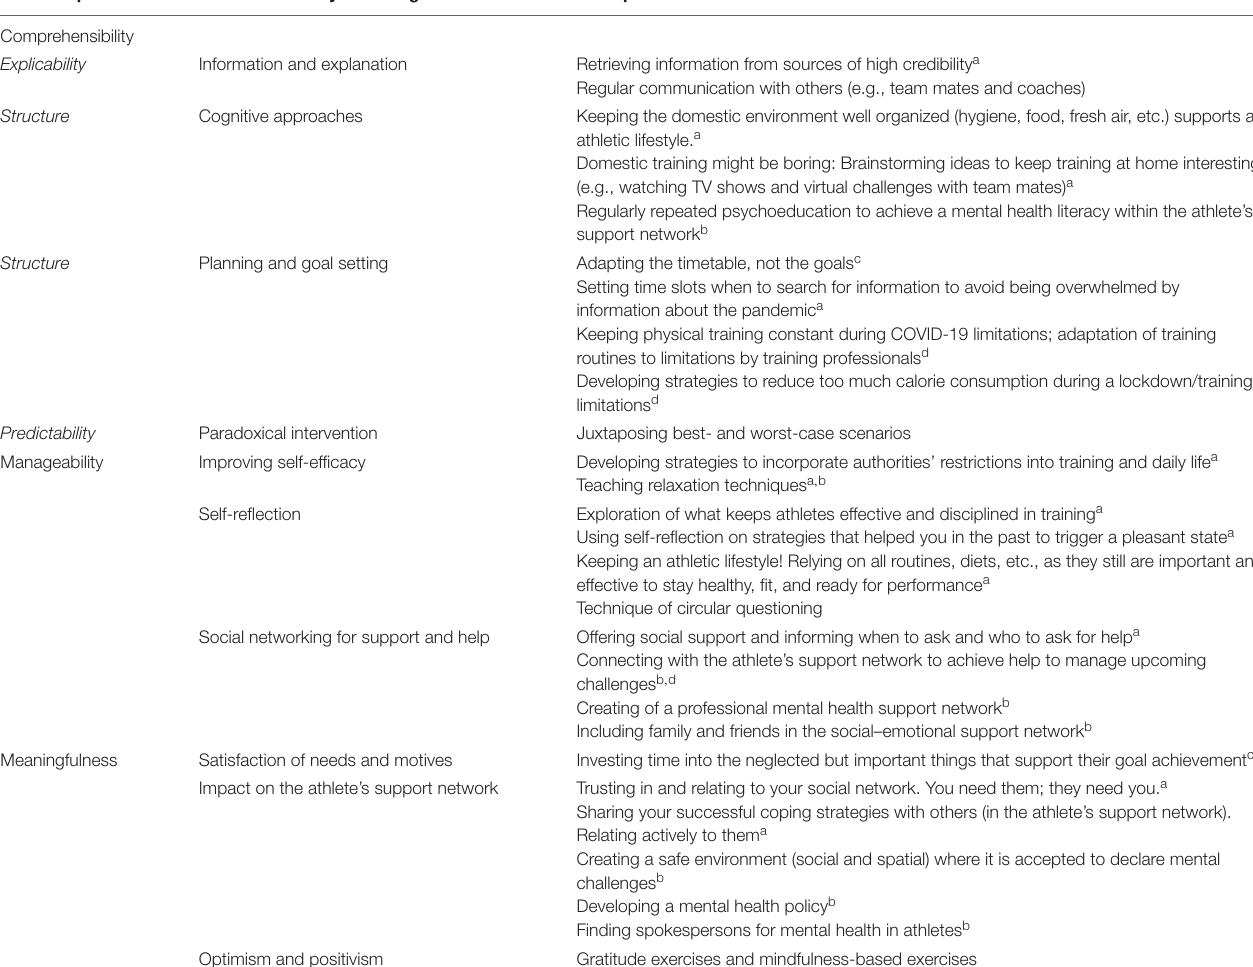
TABLE 1 | Collection of sense of coherence (SoC) enhancing resources for sport psychology practitioners (SPPs) when coping with